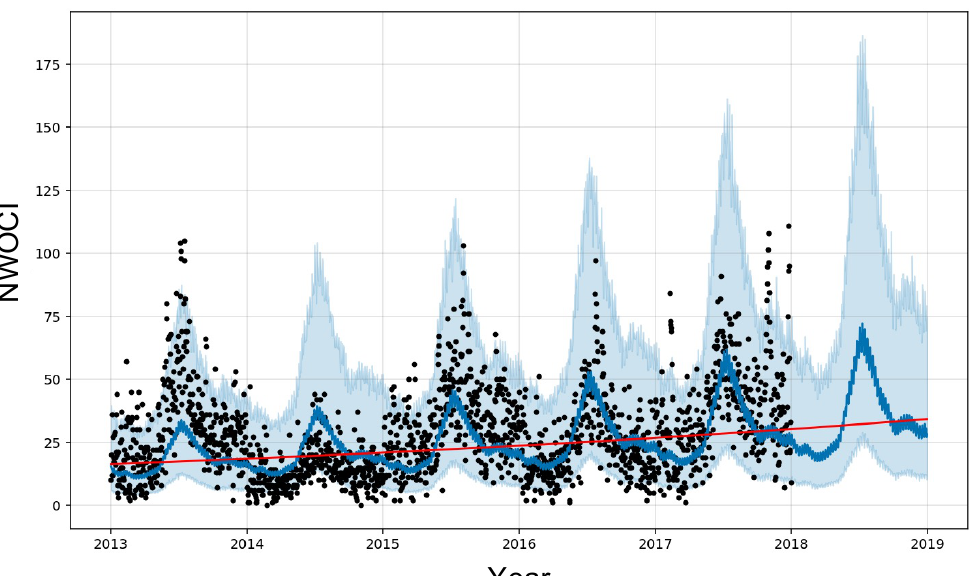
Figure 6. One year forecast result (2018 test data) from Prophet-TPE Model. N.B: The solid blue line shows the average forecast while the solid red line shows the observed trend of NWOCI and the light blue region represents the 80% confidence interval for the forecast uncertainty. Also, the scatter points represent the historical values (daily state level NWOCI) in the training data (2013–2017).